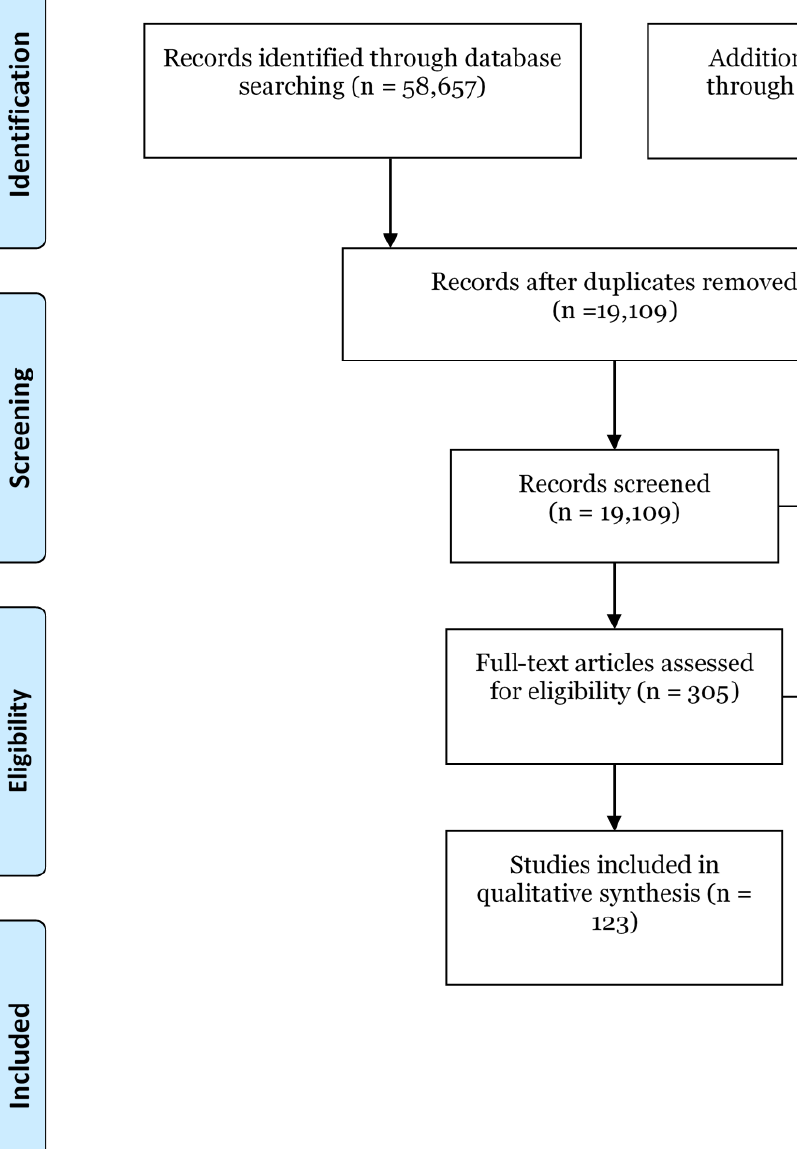
Figure 2. PRISMA diagram of article flow for the